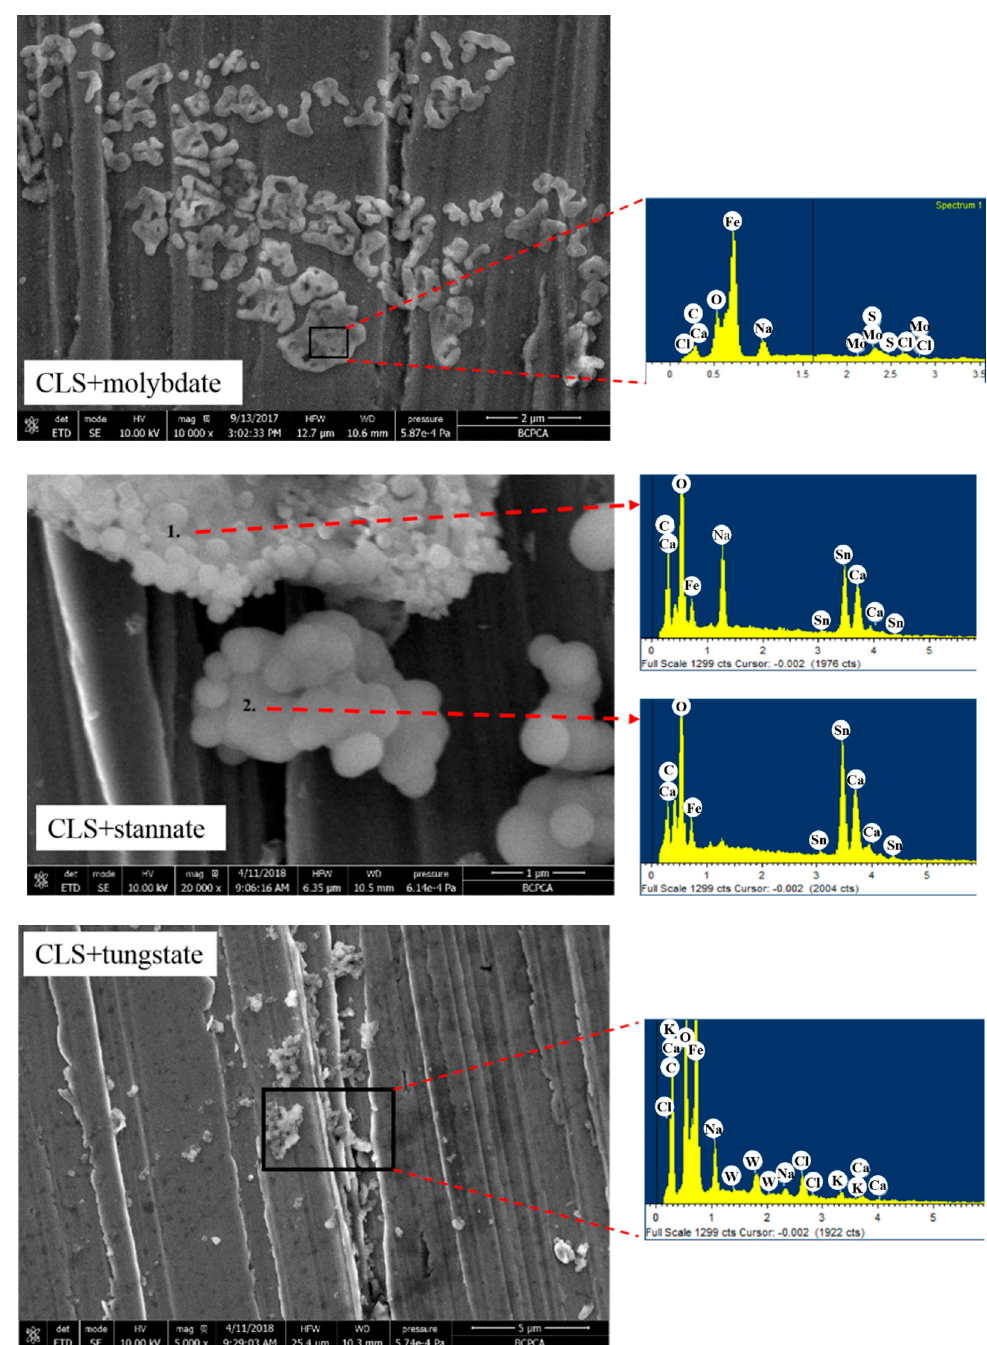
Figure 10. High resolution scanning electron microscope (SEM) images and energy dispersive X-ray spectrometer (EDS) results of the hybrid inhibitors treated steel surface.